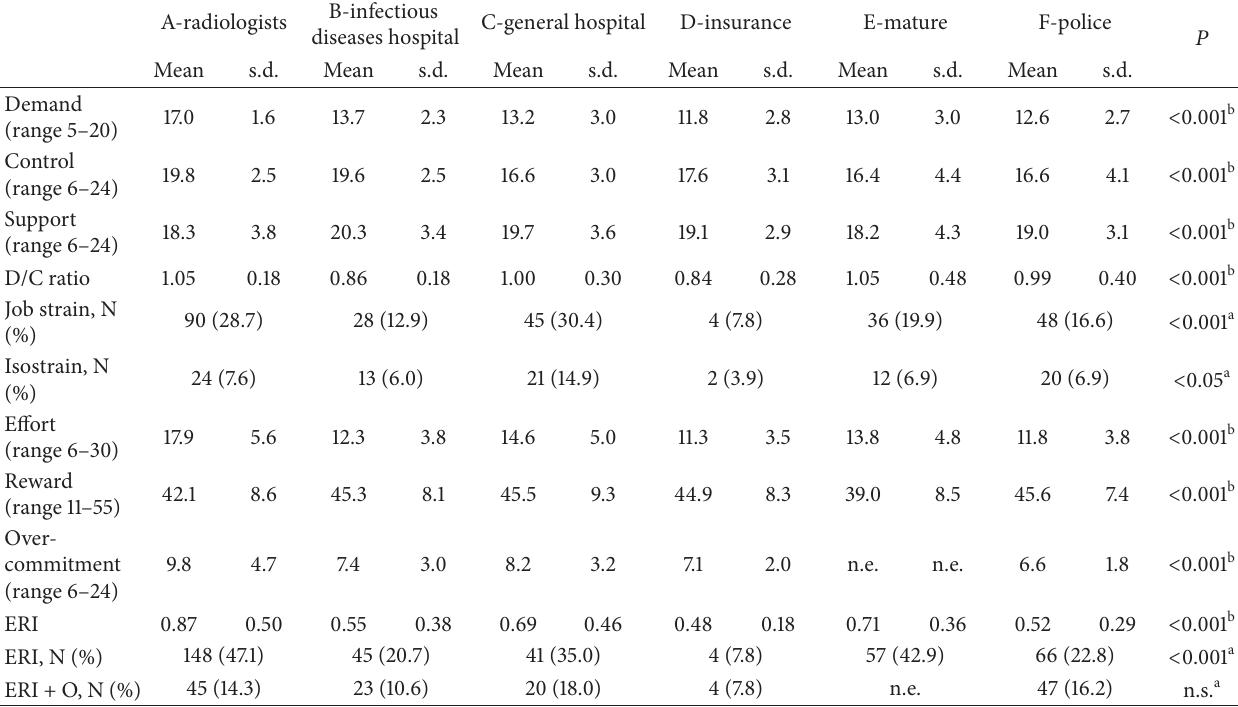
Table 2: Score of the stress-related variables (mean ± standard deviation) and prevalence of workers in the high-risk category.